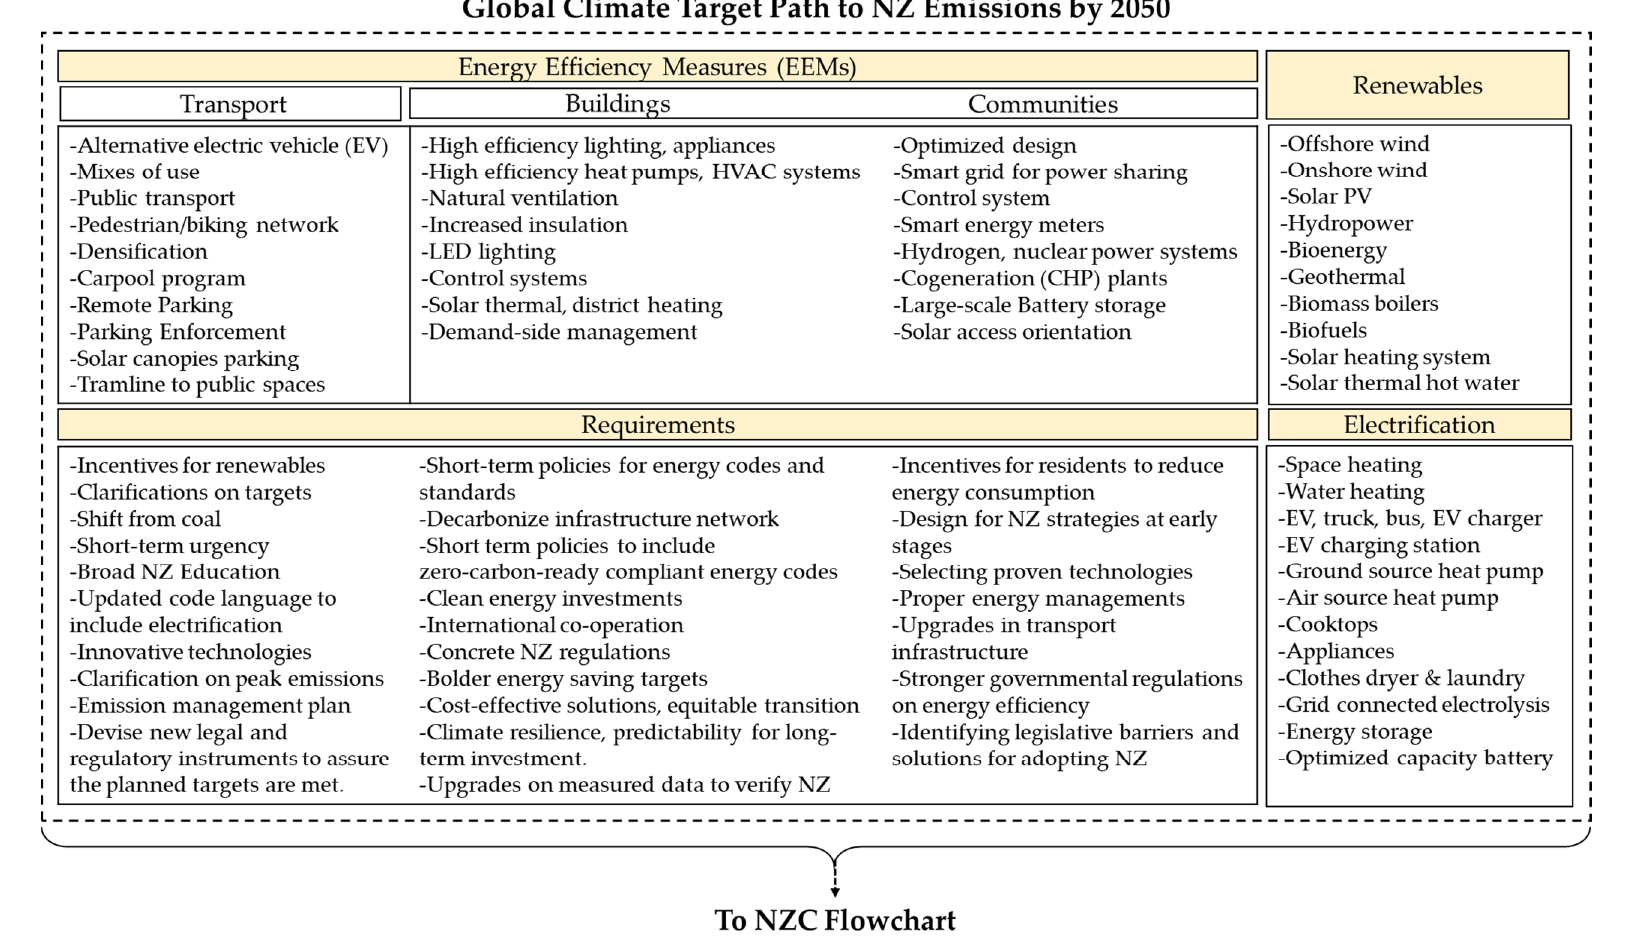
Figure 4. Highlighted climate mitigation strategies to accelerate achieving global NZ emission targets.